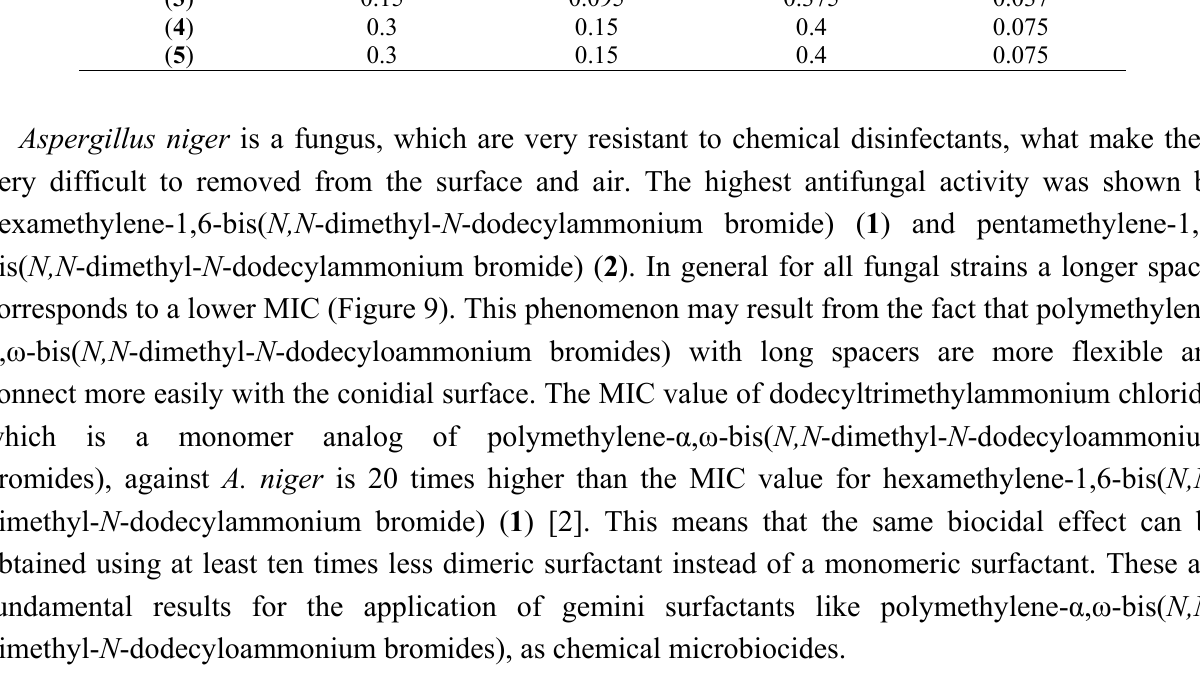
Figure 8. Experimental chemical shifts ( δ dodecylammonium bromide) ( 5 ) vs. the isotropic magnetic shielding ( σ GIAO/HF/3-21G(d,p) calculations for molecules δ